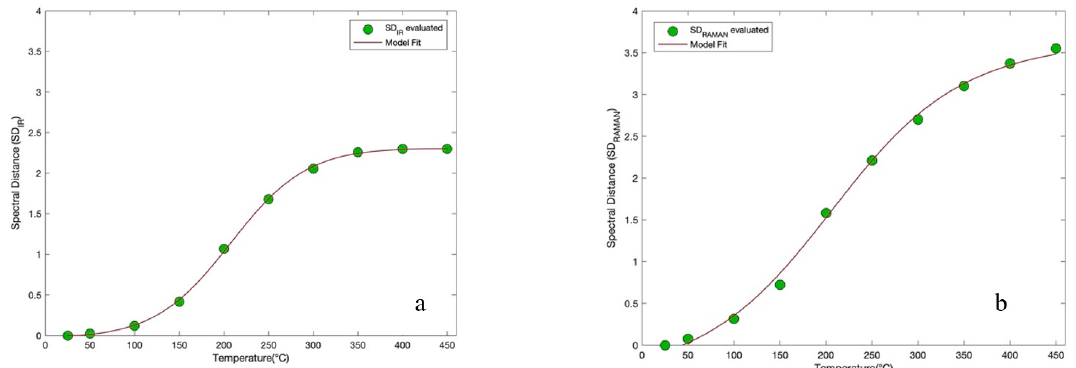
Figure 3. ( a ) Spectral Distance (SD) behavior with respect to temperature for CNTs, for the recorded IR spectra, together with the fit of the model (brown line); ( b ) Spectral Distance behavior with respect to temperature for CNTs, for the recorded IR spectra, together with the fit of the model (brown line) in the temperature range from 25 °C to 450 °C.